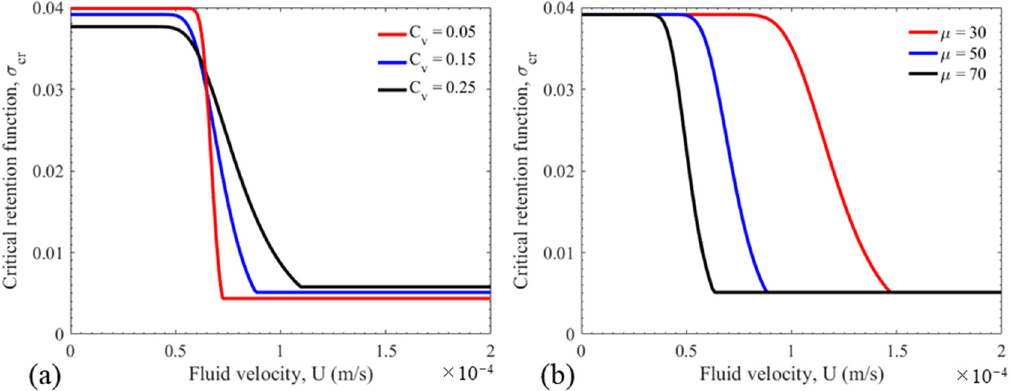
Figure 5. Sensitivity of the critical retention function with respect to the coe ffi cient of variation of the pore size distribution ( a ) and the ratio of oil to water viscosity ( b ).